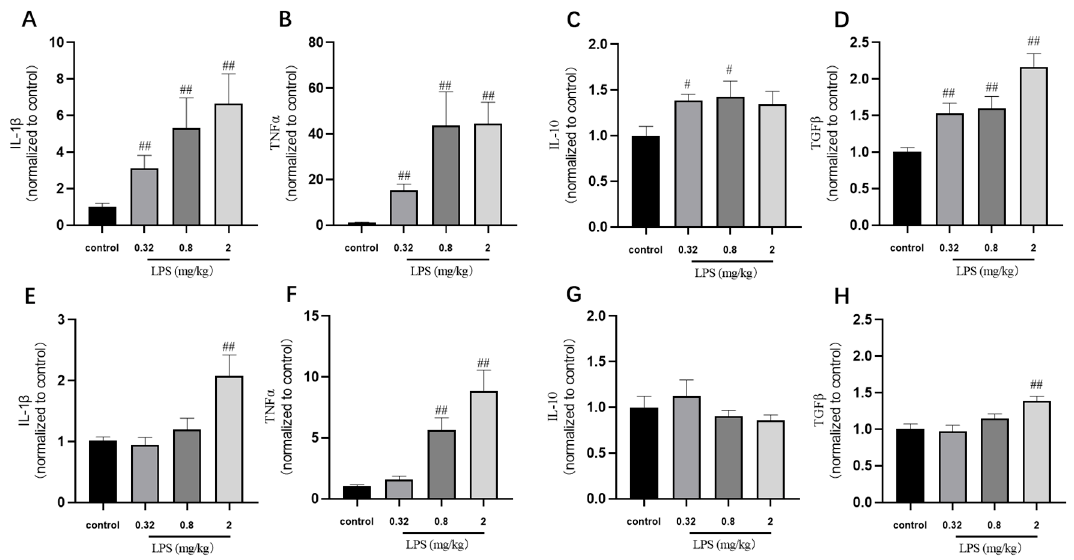
Figure 4. Effects of different doses of LPS on cytokine mRNA levels in the brain of mice. The cytokine IL-1 β , TNF α , TGF β , and IL-10 mRNA levels in the hippocampus ( A – D ) and cortex ( E – H ). Graphs are plotted as mean ± SEM ( n = 6 for each group). Data were analyzed by one-way ANOVA followed by LSD test. # p < 0.05, ## p < 0.01 compared to the control group. 2.5. E ff ects of Di ff erent Doses of LPS on the Status of Microglia and Astrocytes in the Brain of Mice